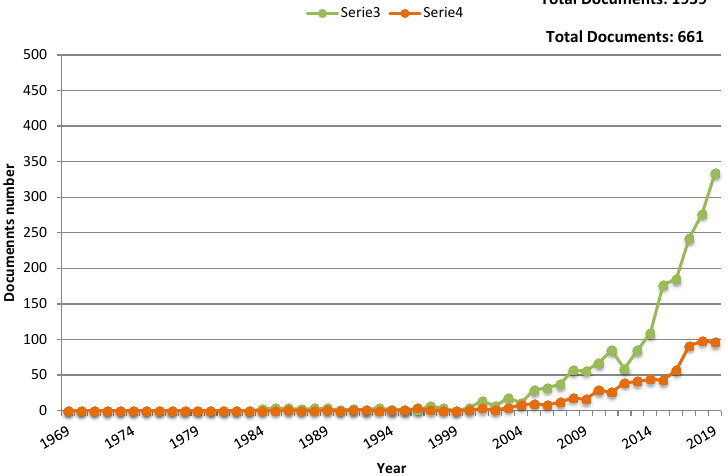
Figure 4. Number of publications per year with titles, abstract or keywords including the terms “flexible electronics” and “flexible gas sensor” (Source: Scopus [2]).